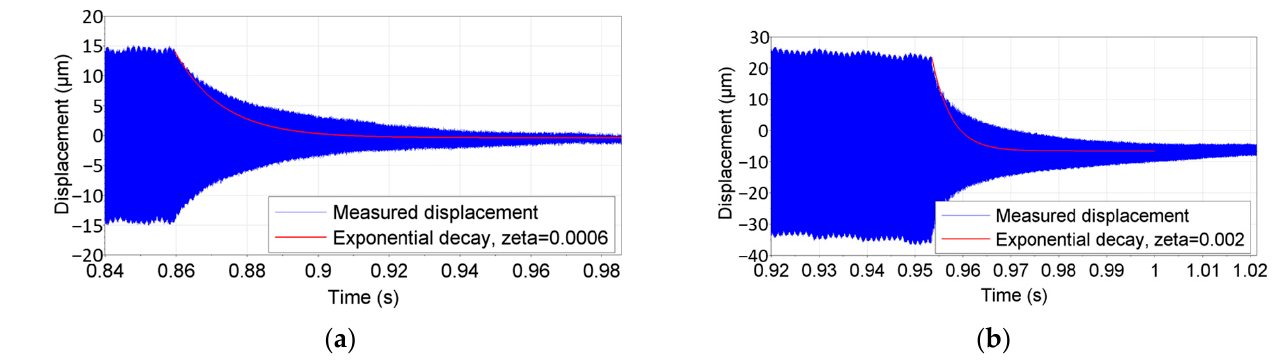
Figure 11. SS 316L D6, UHCF specimen, exponential decay: ( a ) Maximum stress = 150 MPa; ( b ) Maximum stress = 300 MPa.